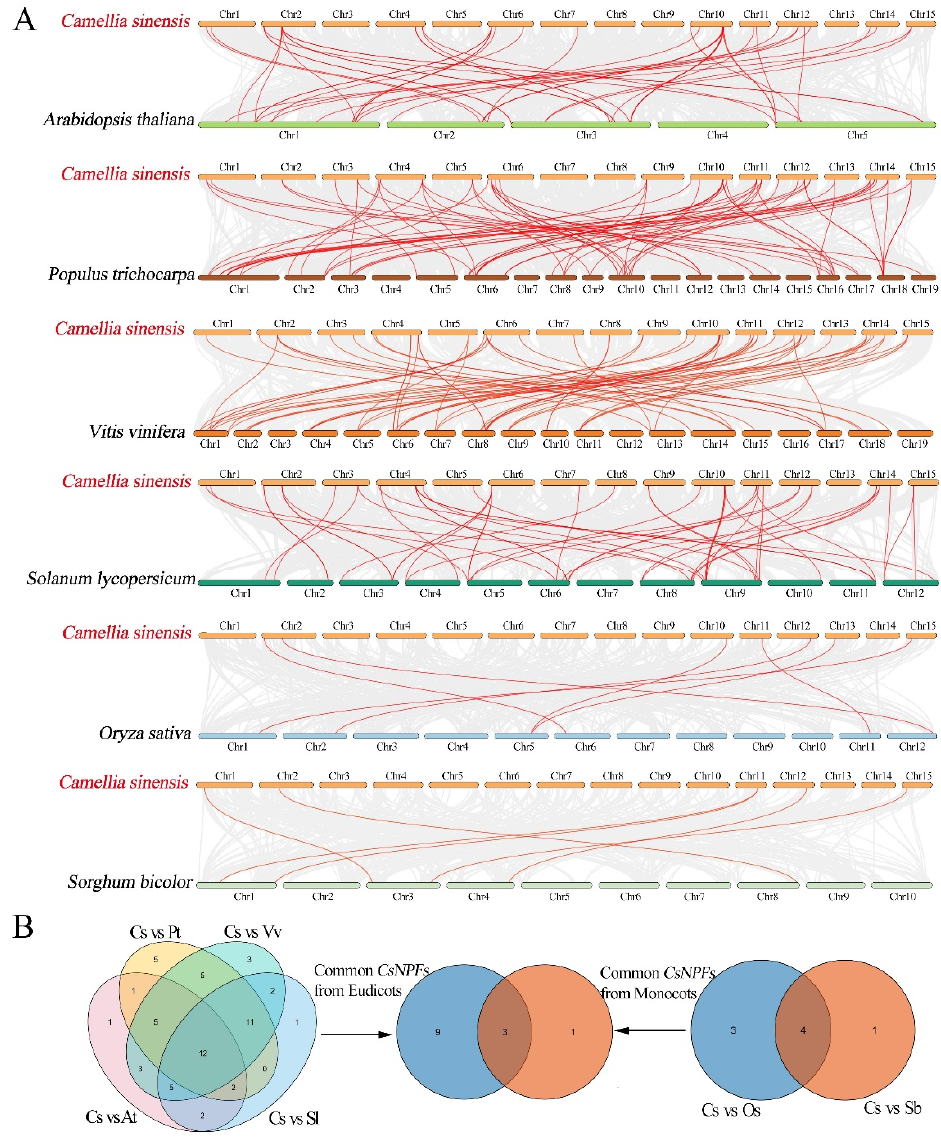
Figure 7. Synteny analyses of the NPF genes between C. sinensis (Cs) and six representative plant species. ( A ) Synteny analyses of the NPF genes between C. sinensis and other six plant species. ( B ) Venn diagram analysis of collinear NPF genes between C. sinensis and other six plant species. Four eudicots include A. thaliana (At), P. trichocarpa (Pt), V. vinifera (Vv) and S. lycopersicum (Sl); 2 monocots include O. sativa (Os) and S. bicolor (Sb).